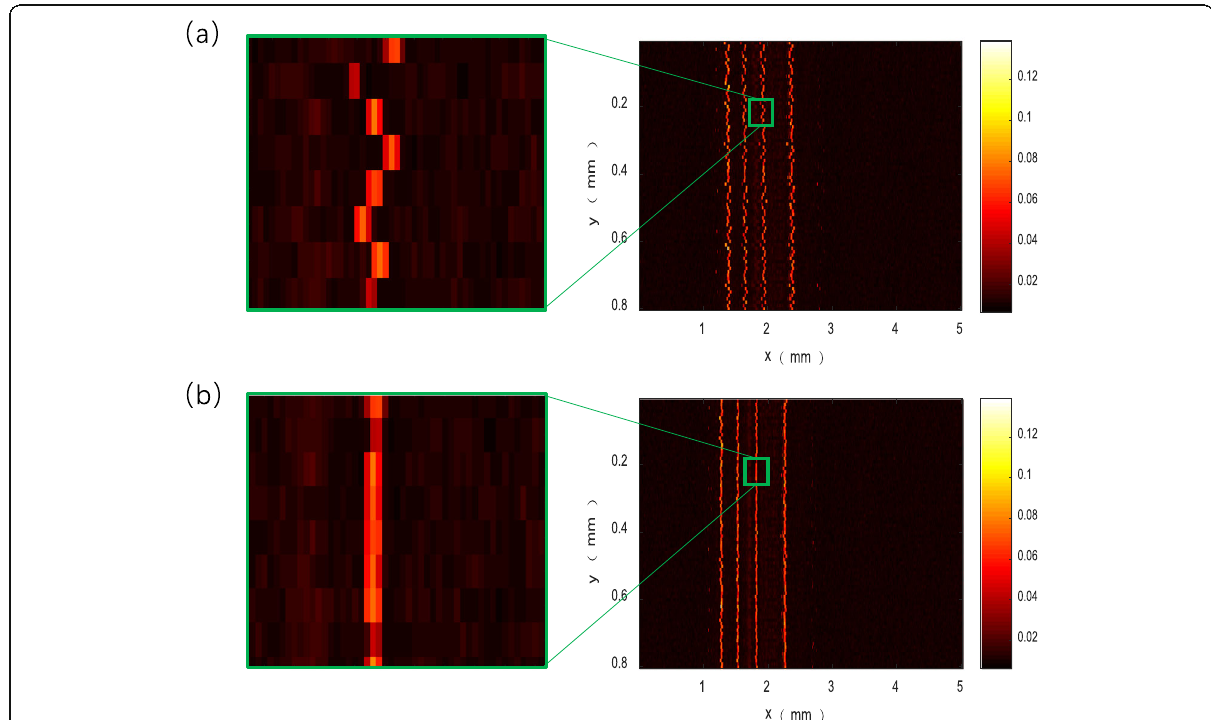
Fig. 8 Multiple B-scans of the same area of four tungsten wires with a diameter of 40 μ m. Photoacoustic MAP images of the tungsten wire ( a ) before correction and ( b ) after